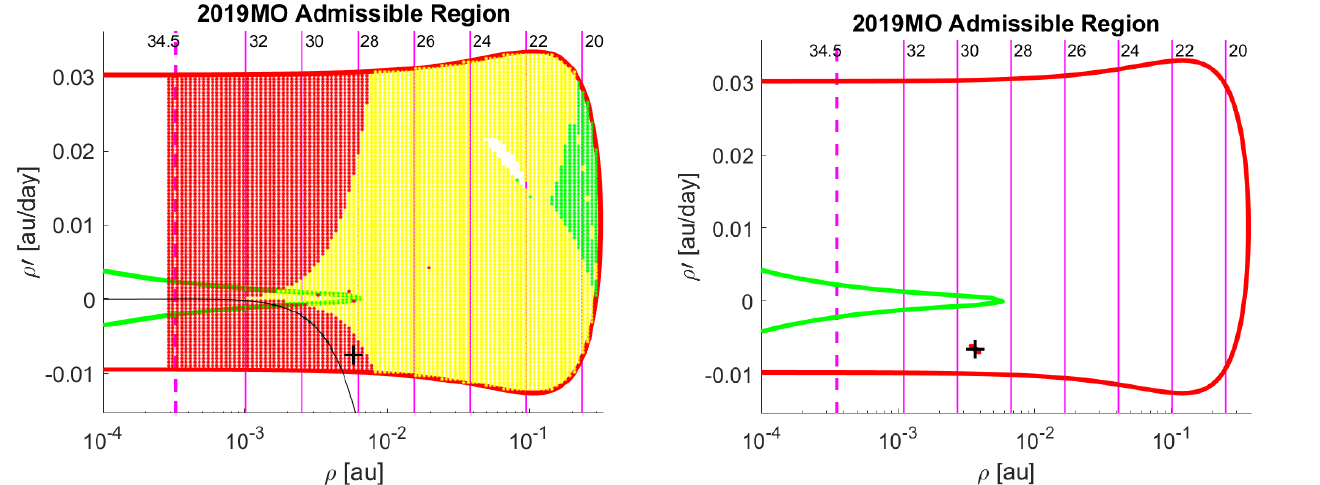
Figure 3. Tool 1 tested on tracklets of four observations (left) and seven observations (right) for asteroid